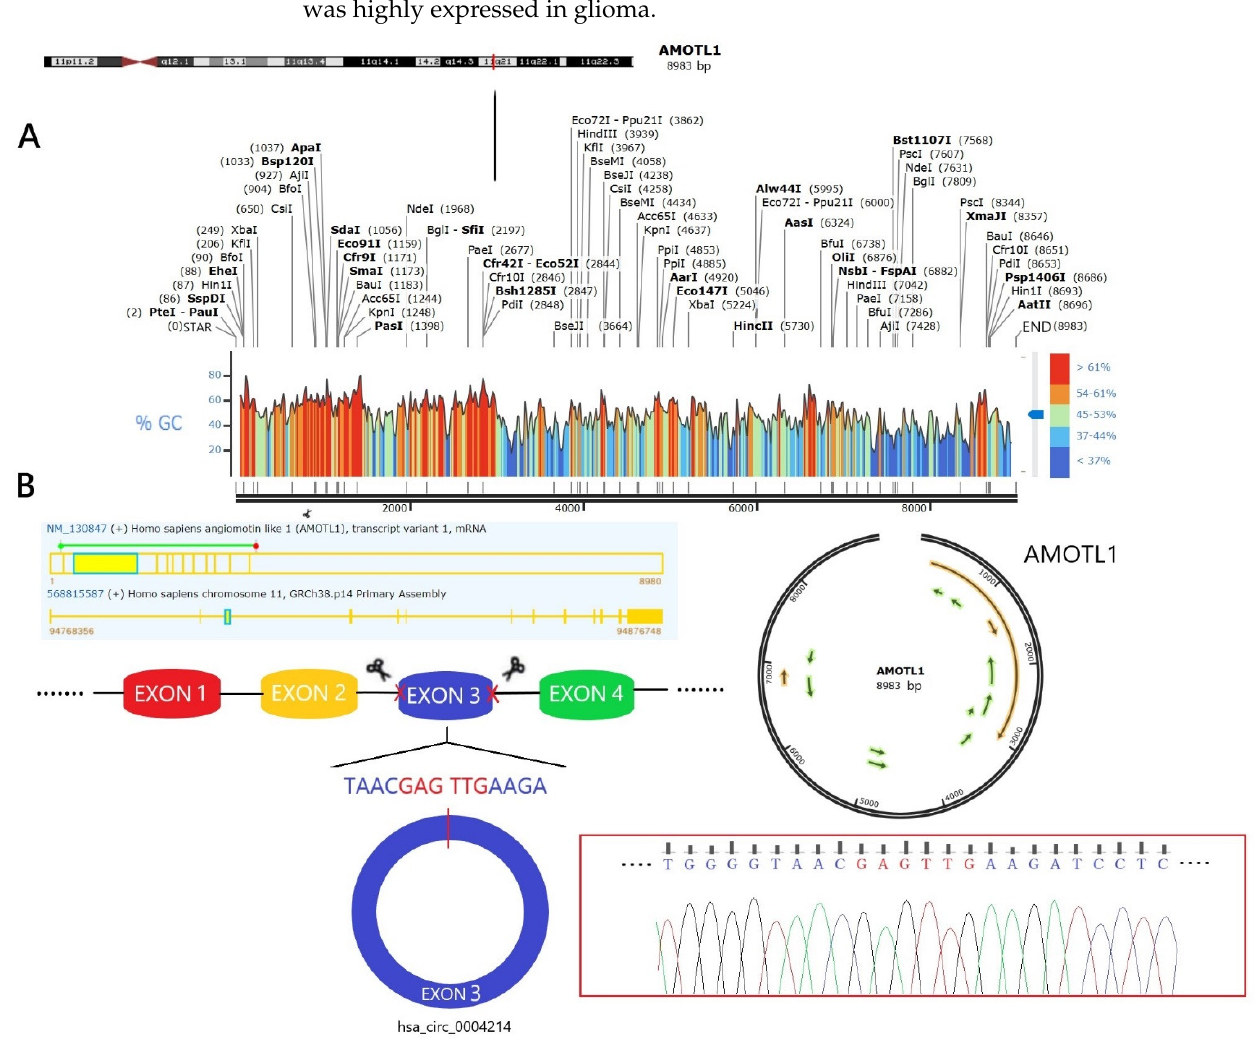
Figure 1. Genetic information of host gene AMOTL1 and hsa_circ_0004214. ( A ) Genetic information of host gene AMOTL1. Full-length gene visualization analysis, including base pair annotation, the location of host gene in Genome-wide, GC ratio (%) and common commercial targets. ( B ) Genetic information of hsa_circ_0004214. Containing host gene exon positions, circRNA alternative splicing, circular docking sequence and basic biological information. Table 3. Diagnostic value of